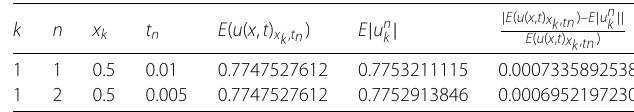
Table 1 β ∼ Binomial(1.0,0.5), α = 1